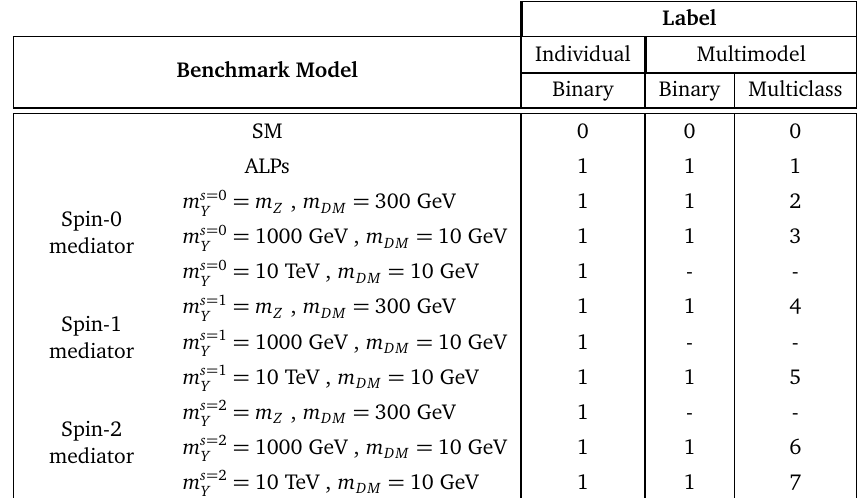
Table 1: Benchmark models and labels used in individual binary, and in multimodel binary and multiclass classifiers. Models without a label are not used to train the corresponding classifier.